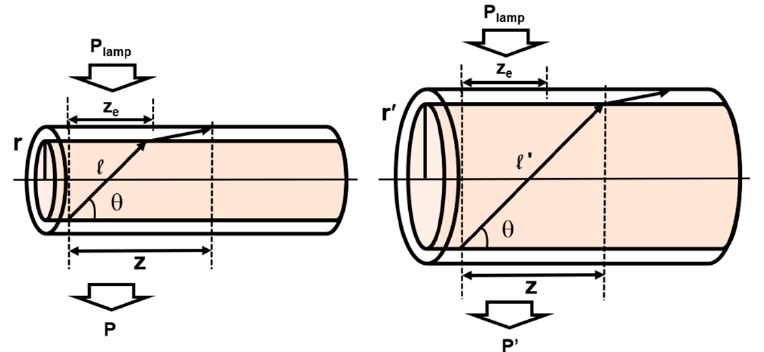
Figure 5. A representative model of the transversal excitation conditions and of the distance covered by rays reflecting at the cladding-air interface in fibers with the same cladding and different core radius (r < r ′ ). P and P ′ represent the power of the transversal excitation light ( P lamp ) that is not absorbed by the doped core and goes through the fiber. Fibers with greater core radius absorb more light transversally than fibers with smaller core radius ( P > P ′ ).